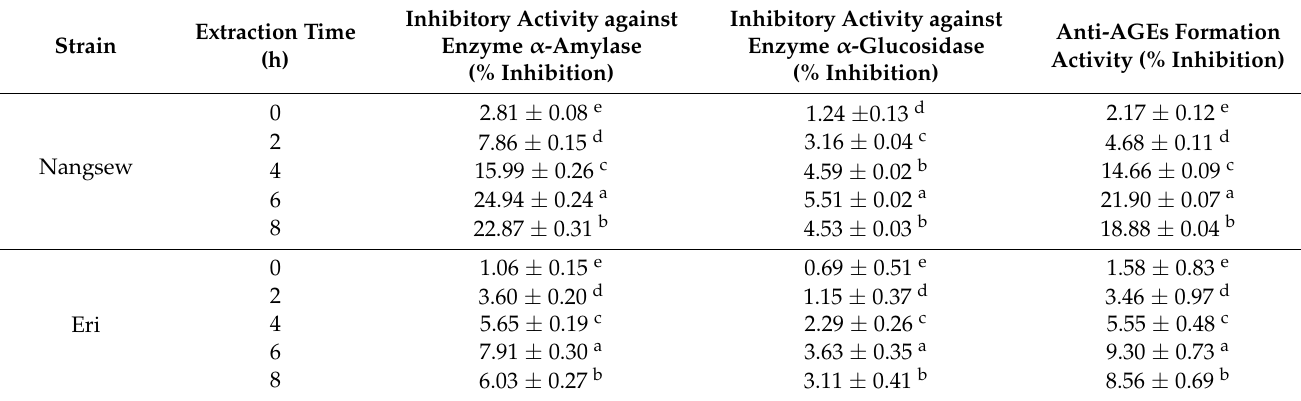
Values are expressed as mean ± standard deviation ( n = 3). Means with different letters in the column within the same strain were significantly different at the level p <